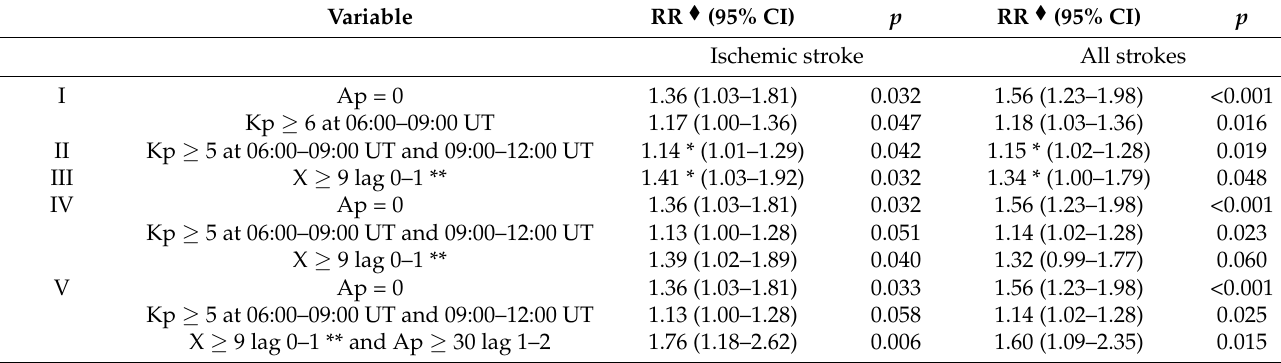
Table 4. Rate Ratios (cid:7) , 95% Confidence Intervals (CI), and p -values for the associations between the occurrence of ischemic stroke and all strokes combined and space weather variables in time-stratified multivariate